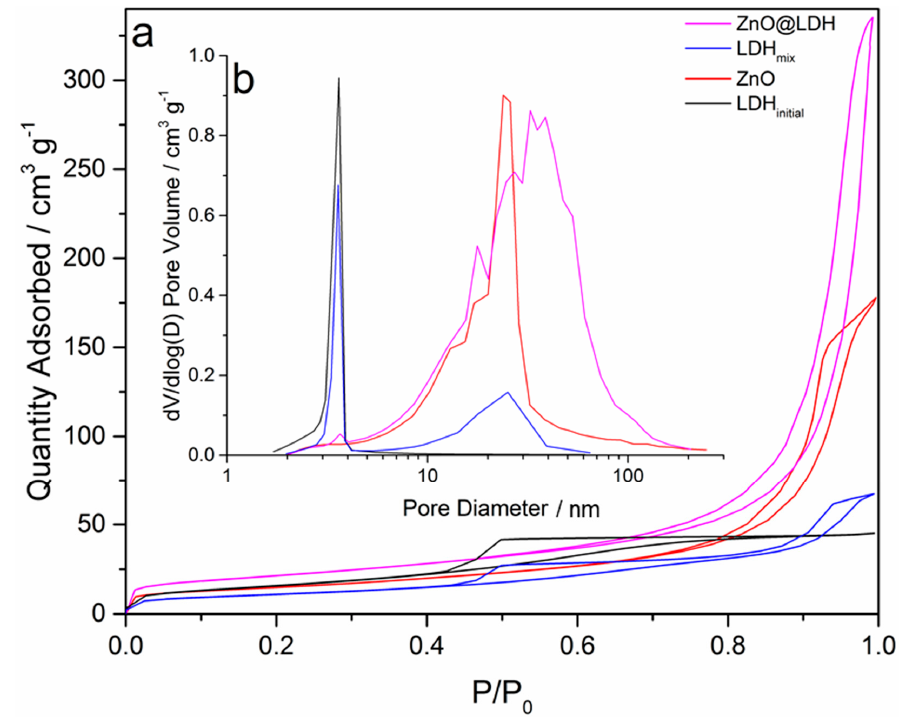
Figure 4. ( a ) Type-IV isotherms, ( b ) pore size distribution for ZnO@LDH composite, ZnO, Mg 2 Al-CO 3 (LDH initial ), and a dry mix of ZnO and LDH initial (LDH mix ). Table 4. Specific surface area, pore diameter, and cumulative pore volume of ZnO, Mg2Al-CO3 (LDHinitial), ZnO-LDH composite, and a mix of ZnO and LDHinitial (LDHmix). Sample